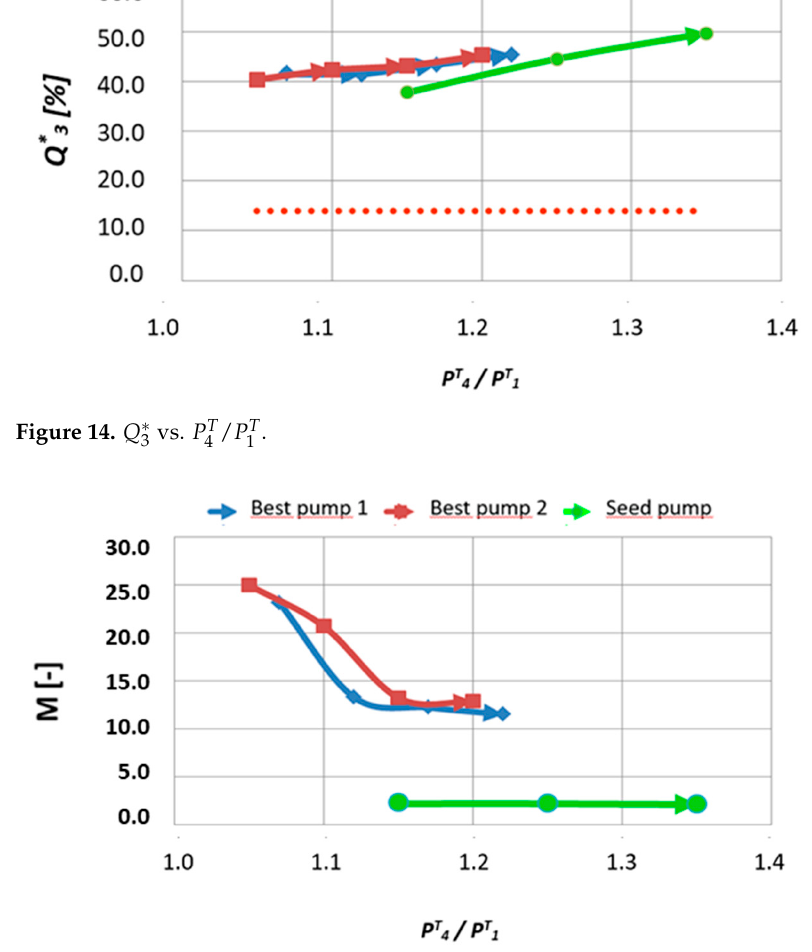
Figure 15. M vs. (cid:2172) (cid:2781)(cid:2176) /(cid:2172) (cid:2778)(cid:2176) .